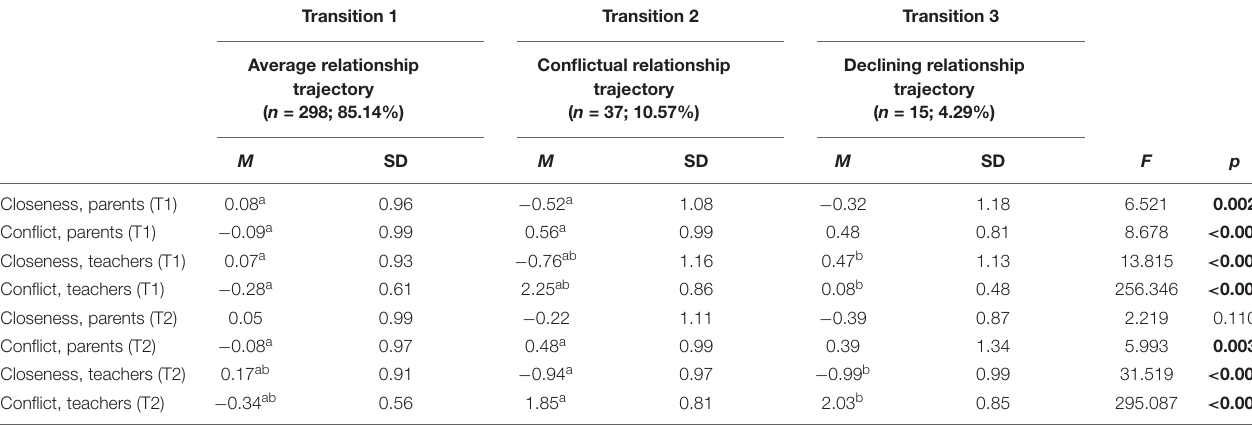
FIGURE 2 | Latent transition probabilities between beginning (T1) and end (T2) of Grade 1. TABLE 6 | Mean differences in latent transitions regarding children’s closeness and conflict with parents and